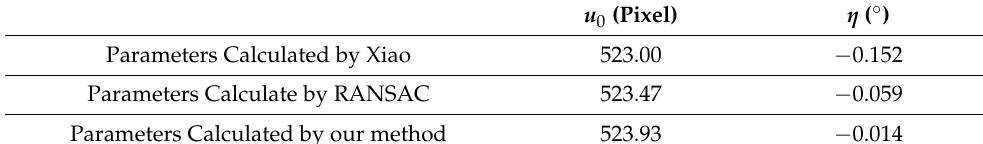
Table 4. The calibration parameters in the Chip data compared with Xiao, RANSAC and our method.